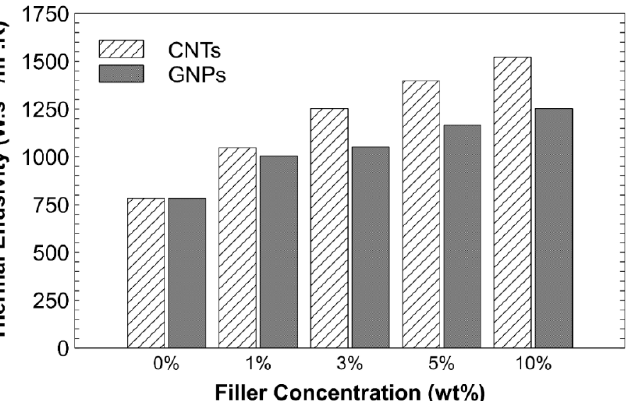
Figure 6. Effect of adding CNTs and GNPs on thermal effusivity of the resultant composites.